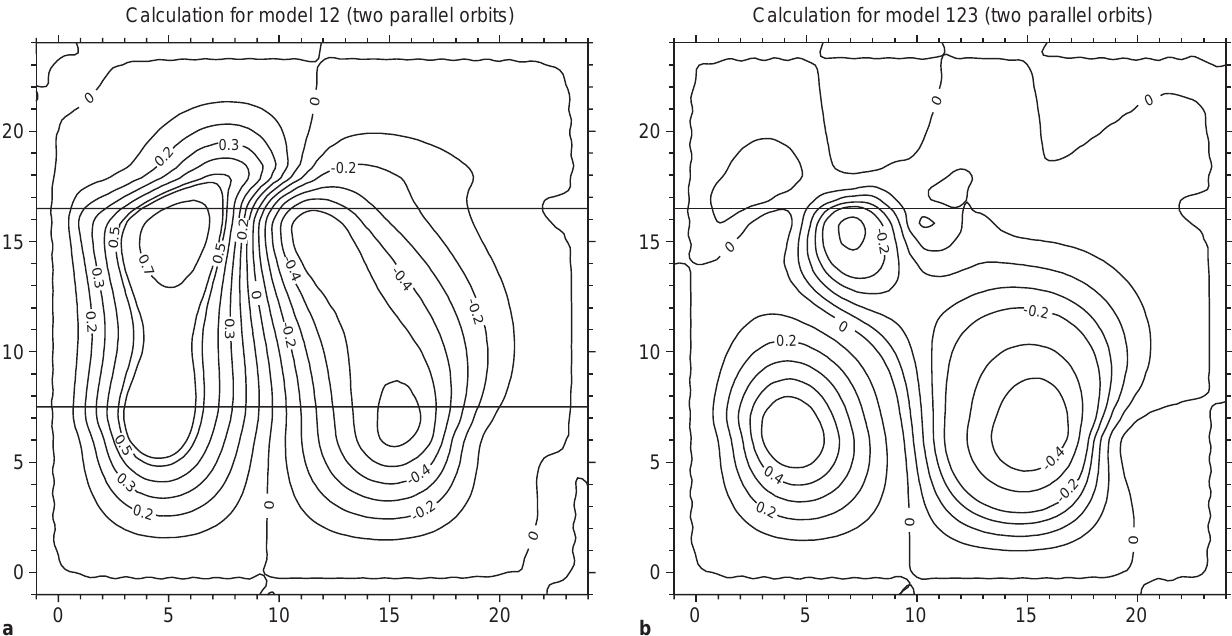
Fig. 4a, b. Convection patterns reconstructed by using the data along two parallel lines (two orbit case). a 2-cell convection; b 4-cell convection